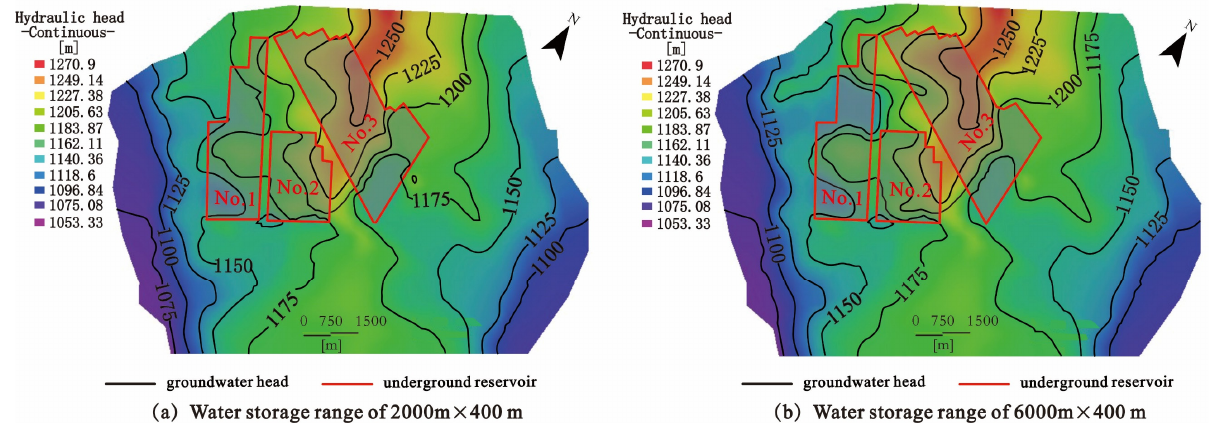
Figure 14. Groundwater contour map of the upper aquifer system under different water-storage ranges: ( a ) 2000 × 400 m, ( b ) 6000 × 400 m.